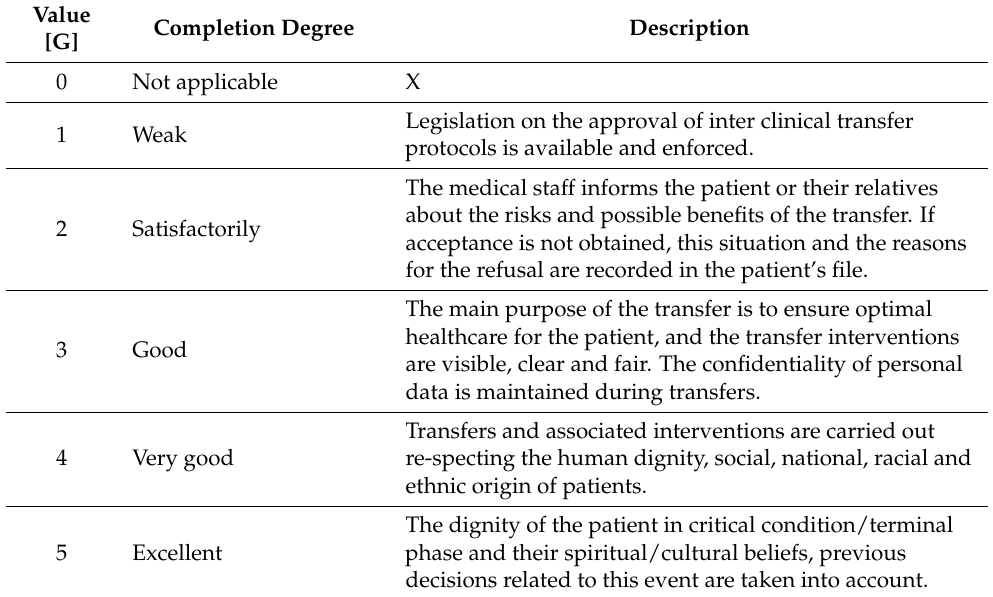
Table 12. Indicator evaluation grid I.B.2—Fair transfer